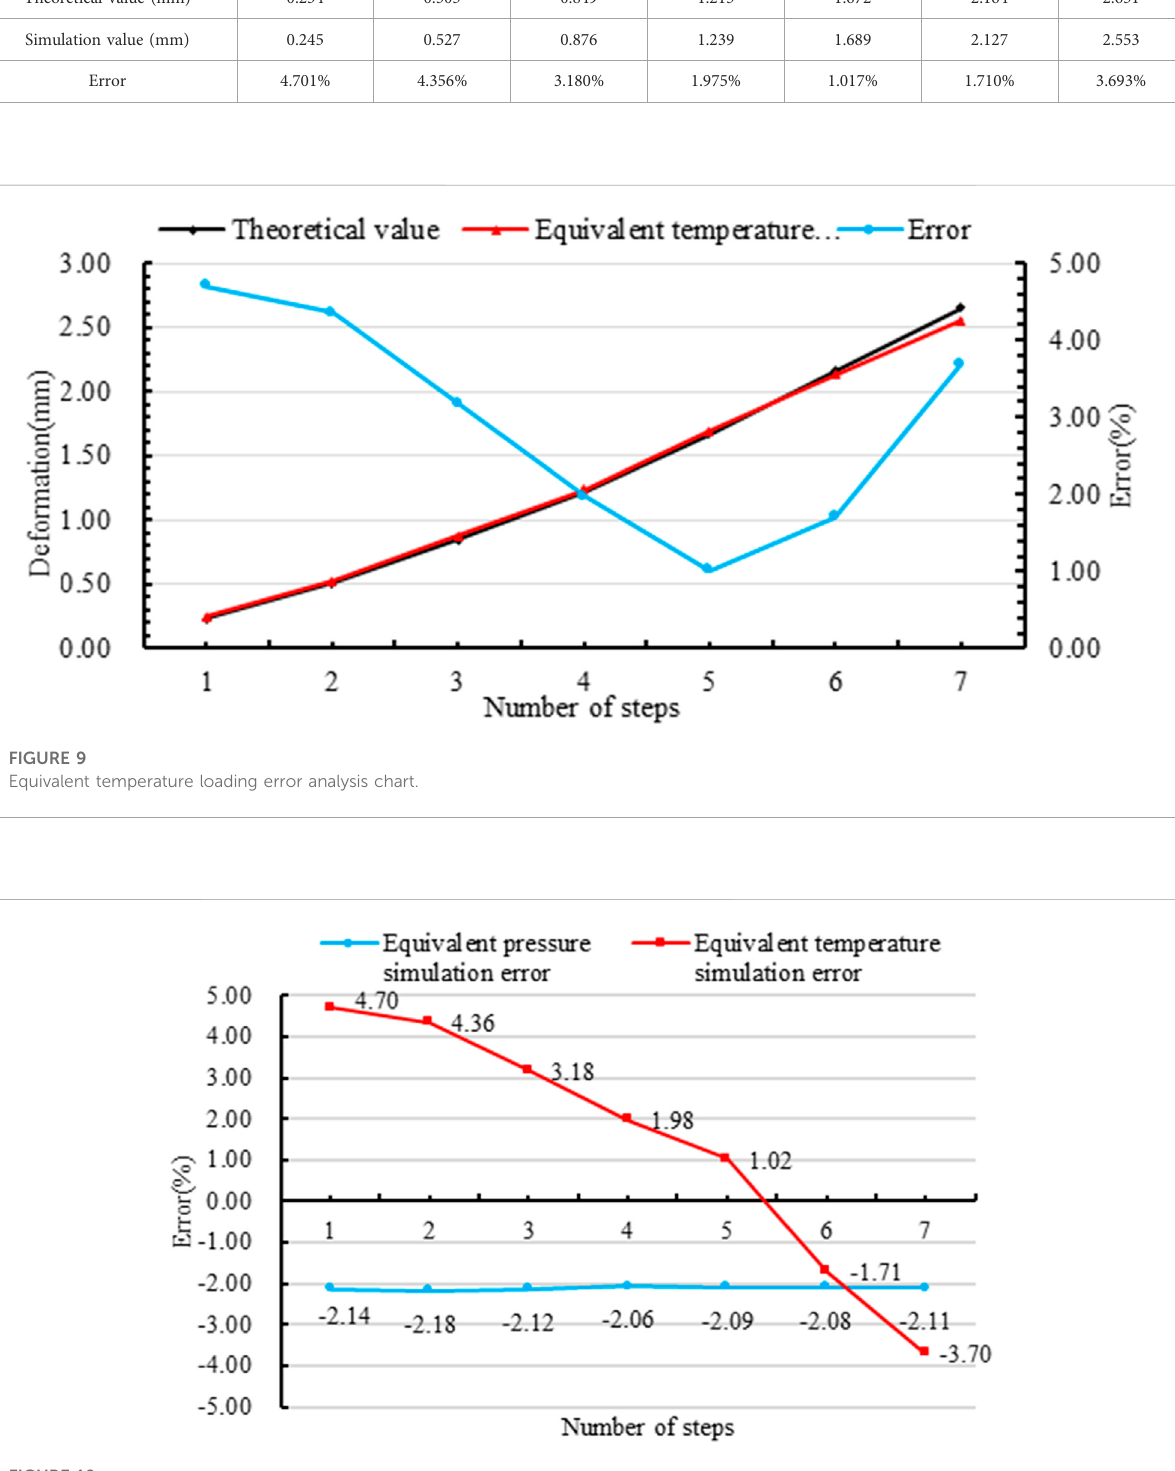
FIGURE 10 Comparison analysis of the error of the two loading